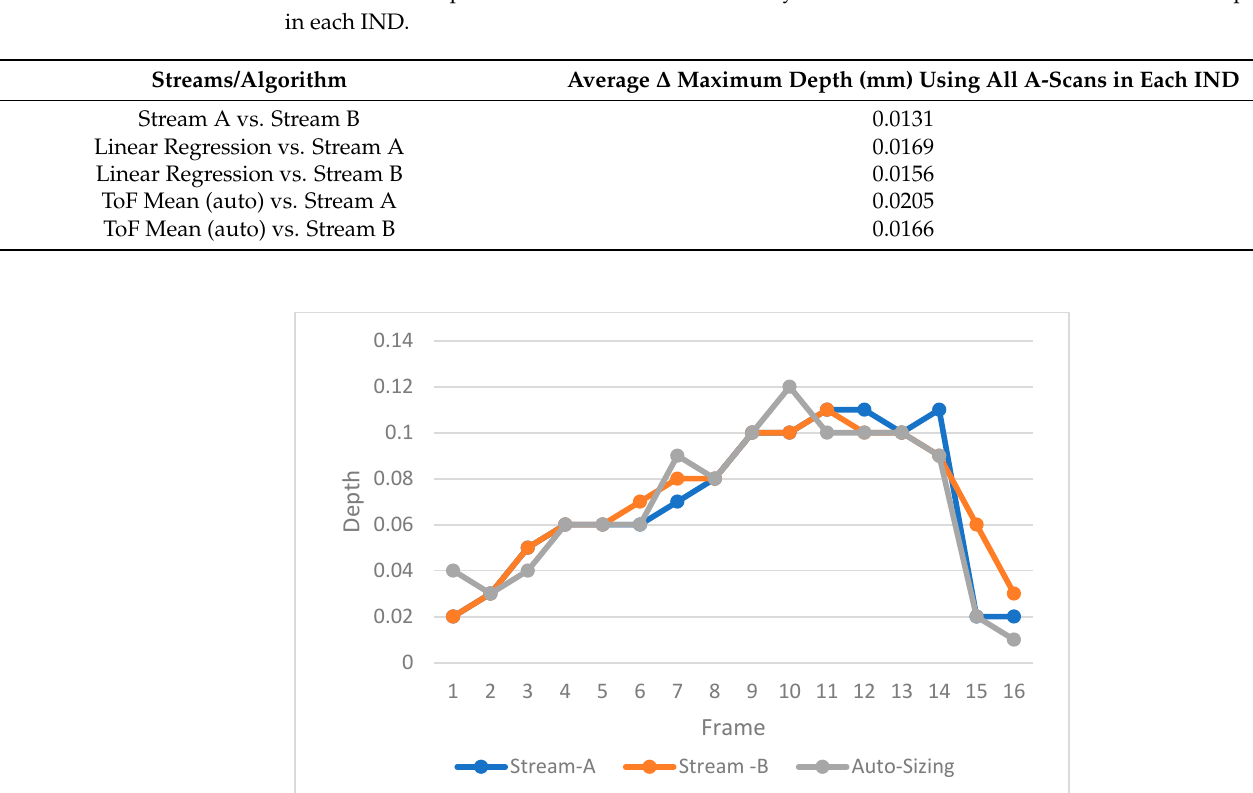
Figure 8. Depth difference between the auto-sizing algorithm using linear regression and the aver- age of streams A and B for an outage data. Table 3 summarizes the overall performance based on the A-Scans with the maxi- mum depth in each IND. As can be seen in the table, by using a linear regression of 80.51%, INDs achieve a maximum depth that is greater than one stream but less than the other stream, or is 0.01 mm higher or lower than both streams. This is based on a total of 118 INDs. Furthermore, the table demonstrates that both algorithms achieved very good rel- ative accuracy. Nevertheless, the linear regression model showed superior performance. Additionally, an attempt was made to merge both algorithms to see if there would be any advantage, but this did not lead to any noticeable improvement over using linear regres- sion alone. Overall, the presented results show real potential for the linear regression al- gorithm to be used in production to automate the detection and sizing of CANDU pres- sure tube flaws. The achieved average delta Δ using the automated depth measurements is reasonably close to the average delta Δ between ‘Stream A’ and ‘Stream B’. Table 3 pre- sents three cases for depth auto-sizing. In the first case, the auto-sizing depth plus or mi- nus 0.01 mm is greater than one stream, but is less than the other stream. In the second case, the auto-sizing depth plus 0.01 mm is higher than both streams. The third case is when the auto-sizing depth minus 0.01 is lower than both streams.